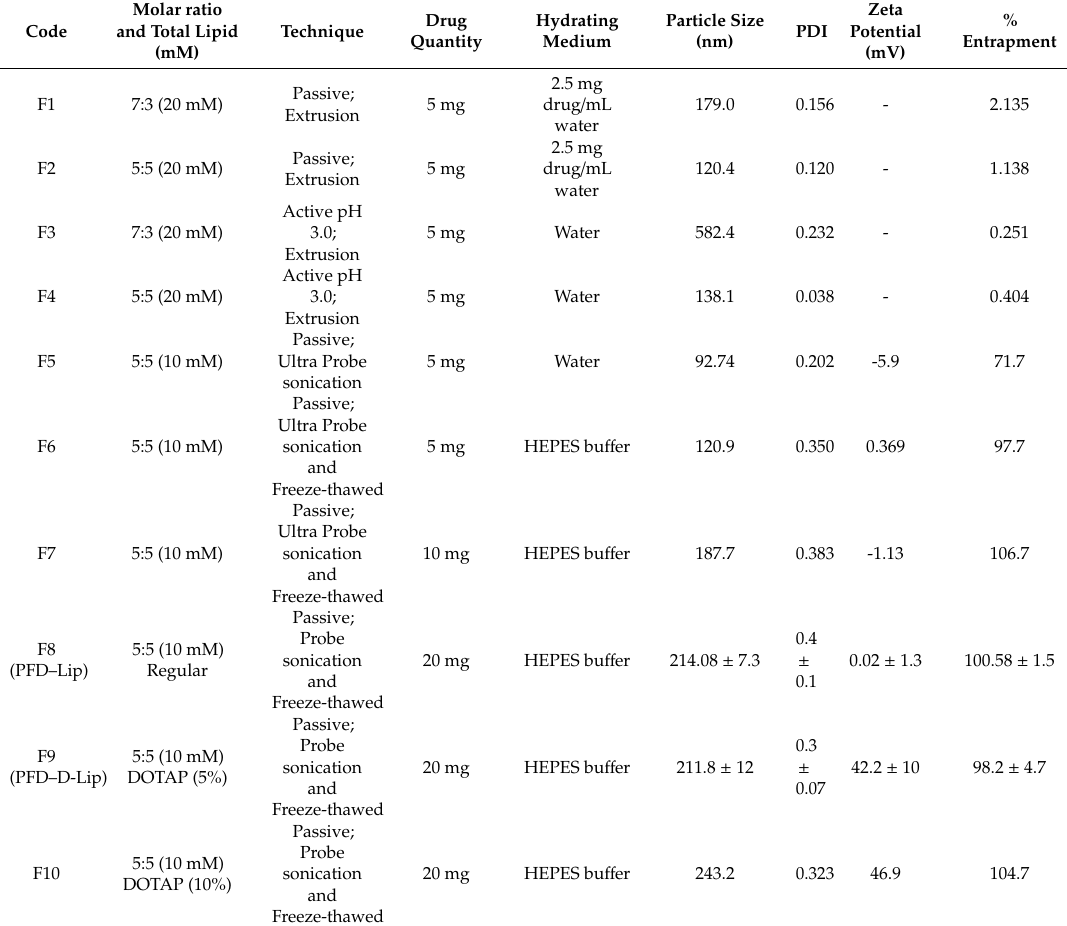
Table 1. Optimization and Characterization of Liposomal